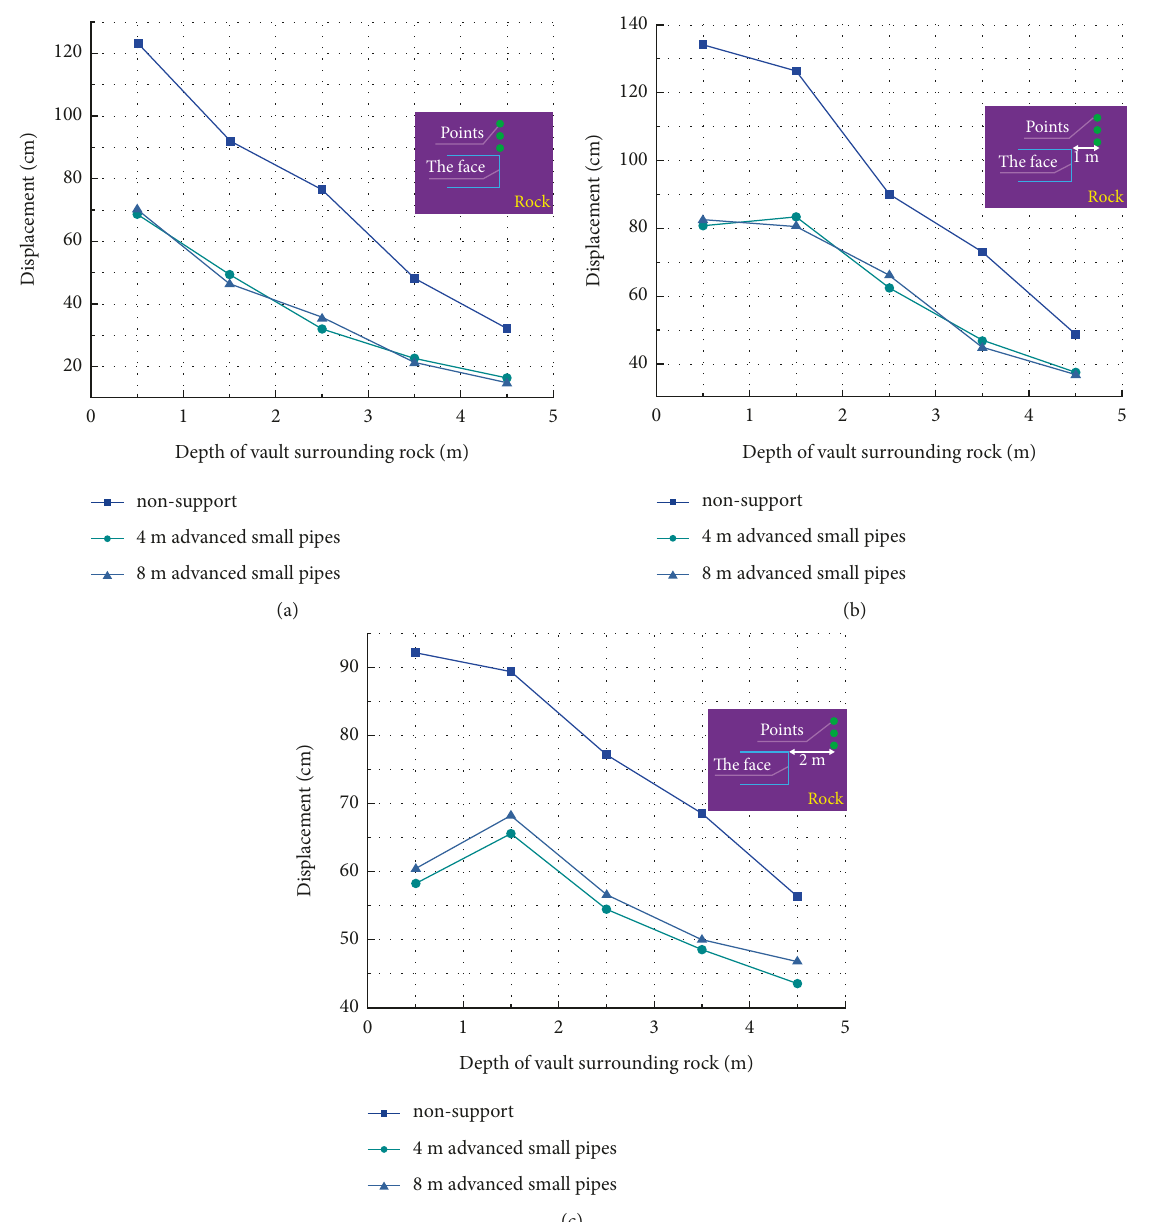
Figure 14: Vault settlement in different sections (enlarged): (a) at the tunnel face; (b) 1m ahead of the tunnel face; (c) 2m ahead of the tunnel